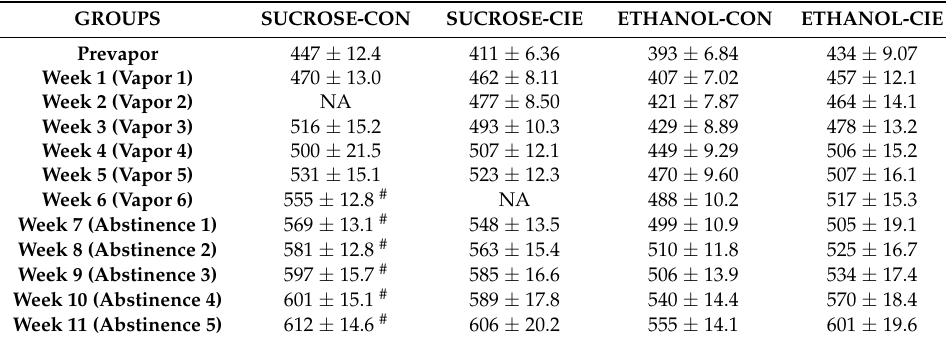
Table 1. Body weights of rats did not differ between